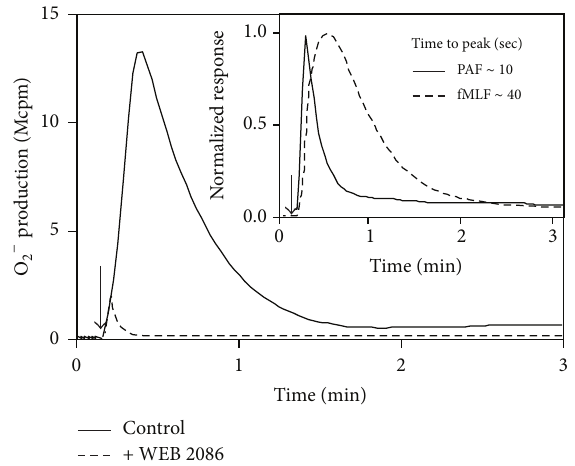
Figure 5: The PAF-induced neutrophil response is primed by TNF- 𝛼 and inhibitors of actin polymerization. Human neutrophils were incubated at 37 ∘ C for 20 min with the priming agents TNF- 𝛼 (10ng/mL; black bars) or 5 min with either CytB (5 𝜇 g/mL; grey bars) or latrunculin A (50 ng/mL; white bars). Control cells were incubated at the same conditions but in the absence of any priming agents. The cells were then activated with fMLF (100nM) or PAF (100nM), and the release of superoxide was recorded continuously. Data are expressed as fold increase of the peak values of the response from primed cells compared to nonprimed control (mean ± SEM; 𝑛 = 3 ). The dashed line in the graph denotes the value expected with a nonactive priming